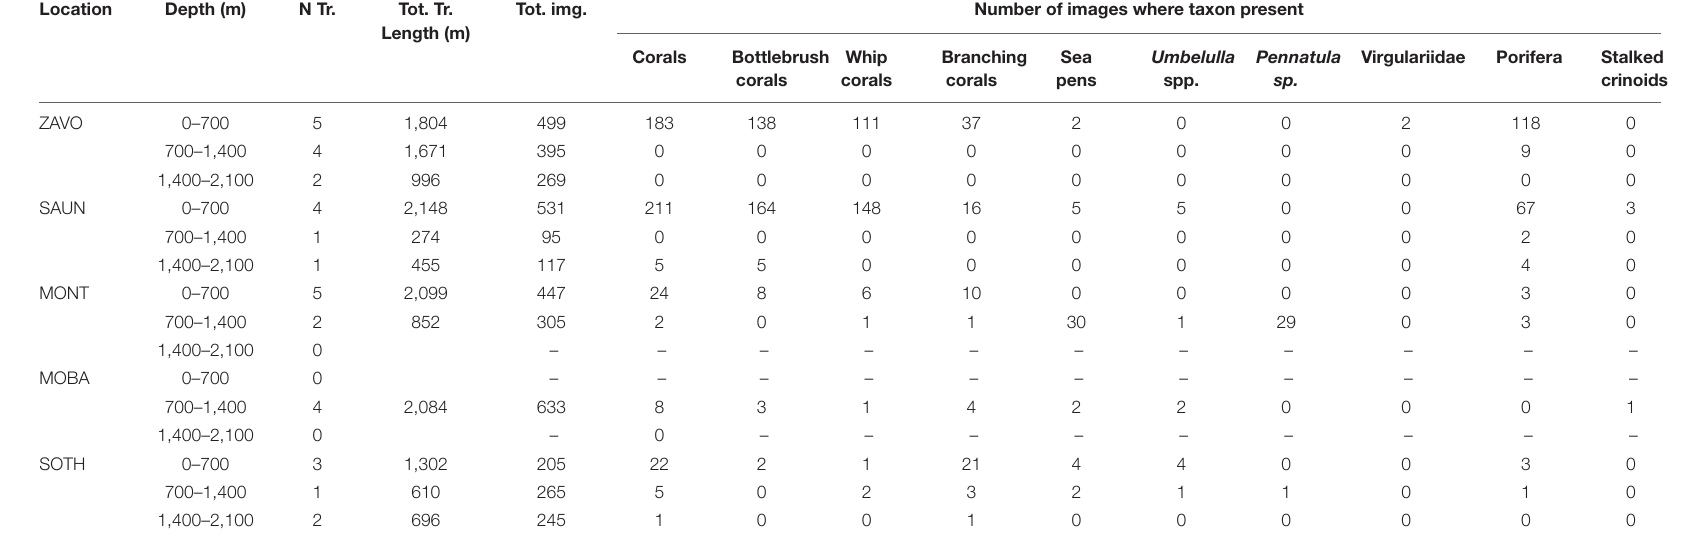
TABLE 3 | Number and total length of transects, total number of images and number of images for which key VME indicator species were recorded at each study site by depth zone.